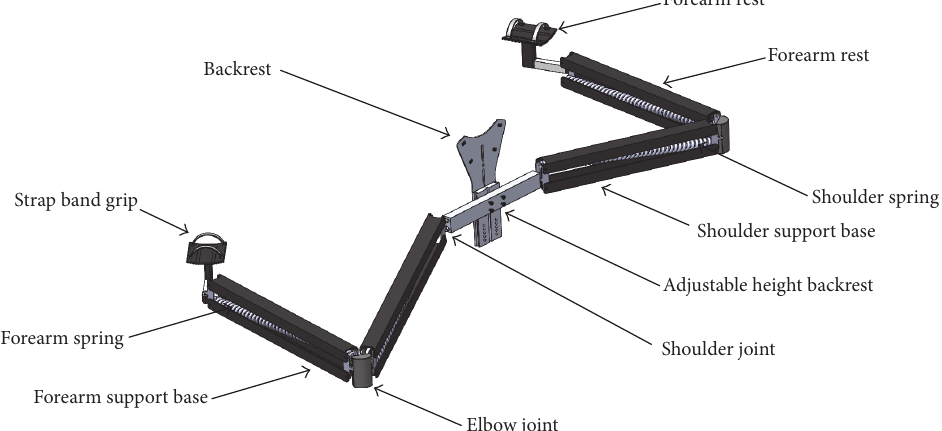
Figure 1: Schematic diagram of the system used in the evaluation and design of the final biomechanical model for the industrial activities.